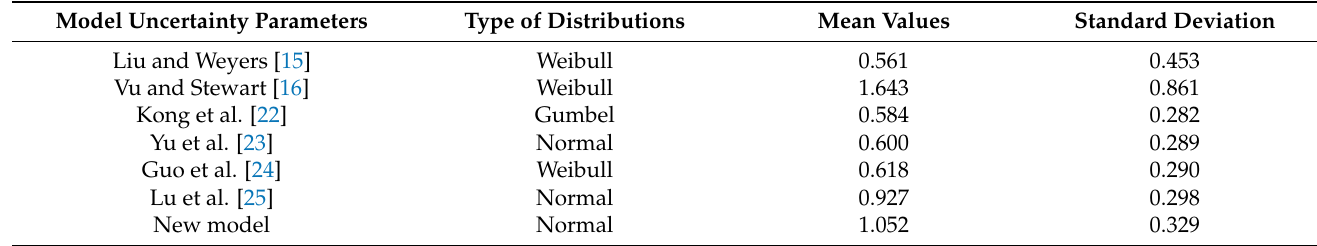
Table 6. Probability characteristics of the uncertainty parameters of the model. Model Uncertainty